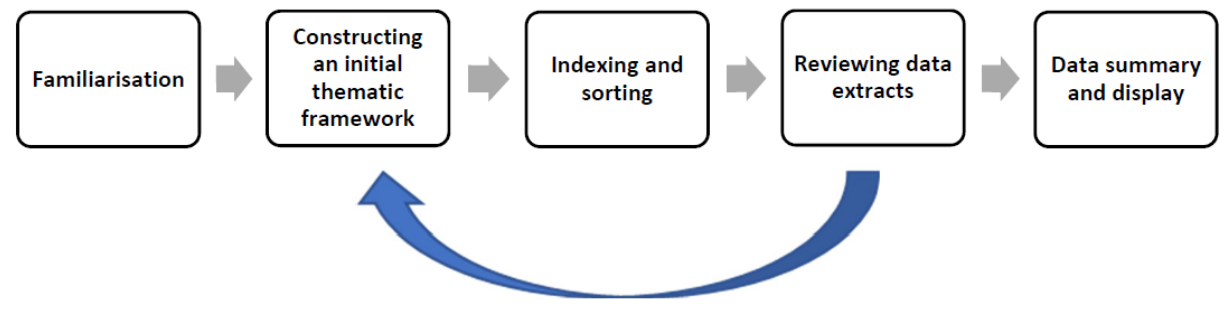
Figure 4. Framework analysis process [61].